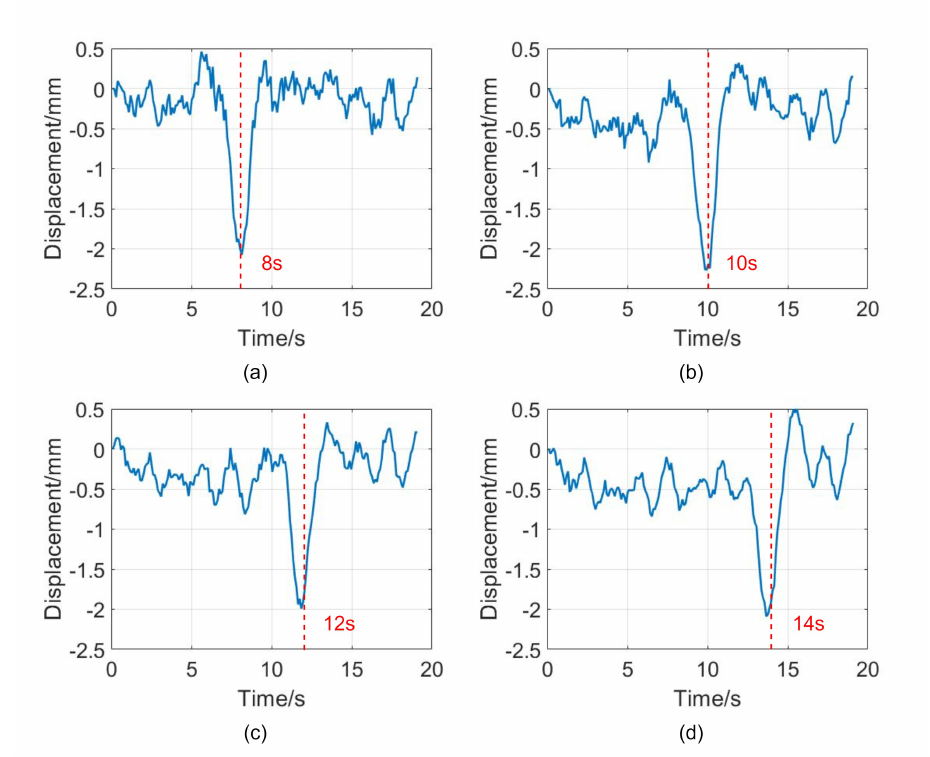
Figure 15. Deformation of different positions is measured at 11:16 on 27 August 2021. ( a ) represents the displacement of point 1. ( b ) represents the displacement of point 2. ( c ) represents the displacement of point 3. ( d ) represents the displacement of point